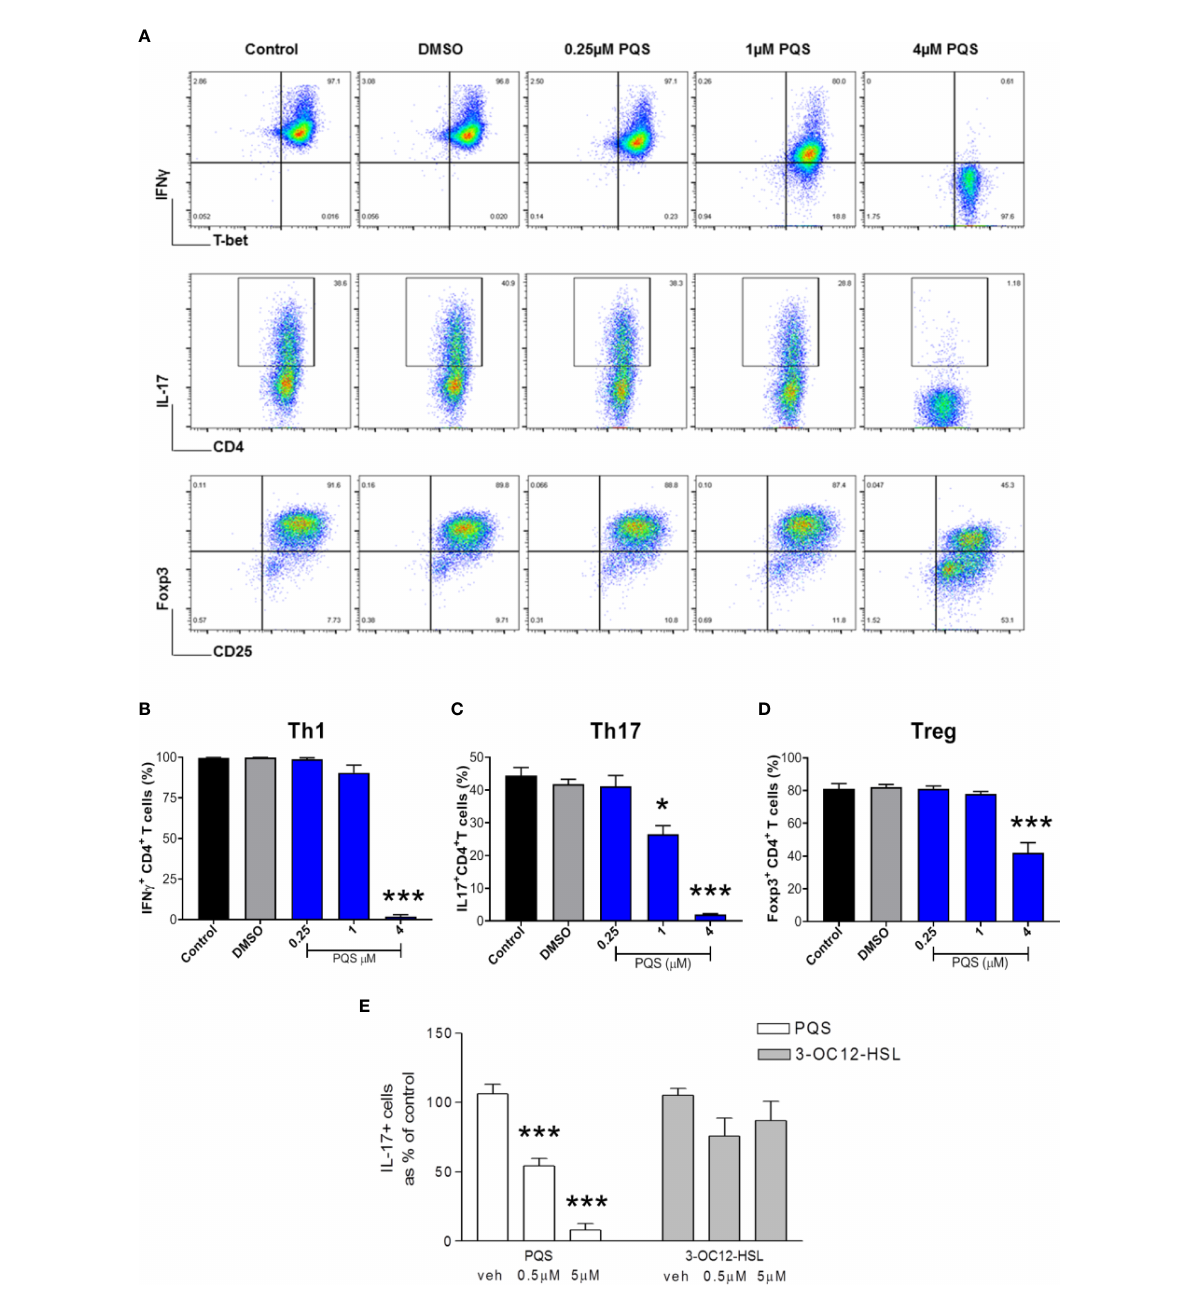
FIGURE 3 PQS inhibits mouse T cell differentiation. (A) Representative FACS plots of mouse leucocytes differentiated to T helper cells in the presence of up to 4 m M PQS. Top, middle and lower rows are Th1, Th17 and Treg-differentiation cultures, respectively. Quanti fi cation of (B) Th1, (C) Th17 and (D) Treg cells; *p<0.05, ***p<0.001 (n = 6), (E) PQS at 0.5 or 5 m M reduced the generation of IL-17+ T cells in contrast the homoserine lactone 3-OC12-HSL. ***P<0.001 (PQS n=3; 3-OC12-HSL n = 4) (One way ANOVA; Bonferroni post hoc